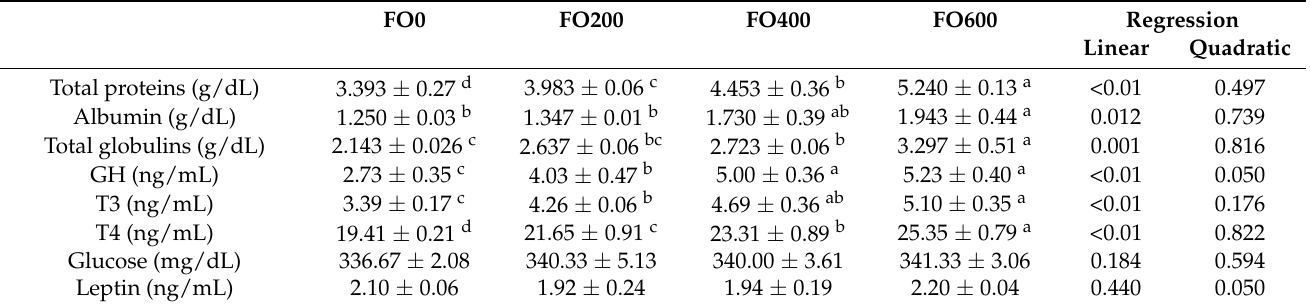
Table 7. Effect of Dietary FO Supplementation on Serum Biochemical Parameters.